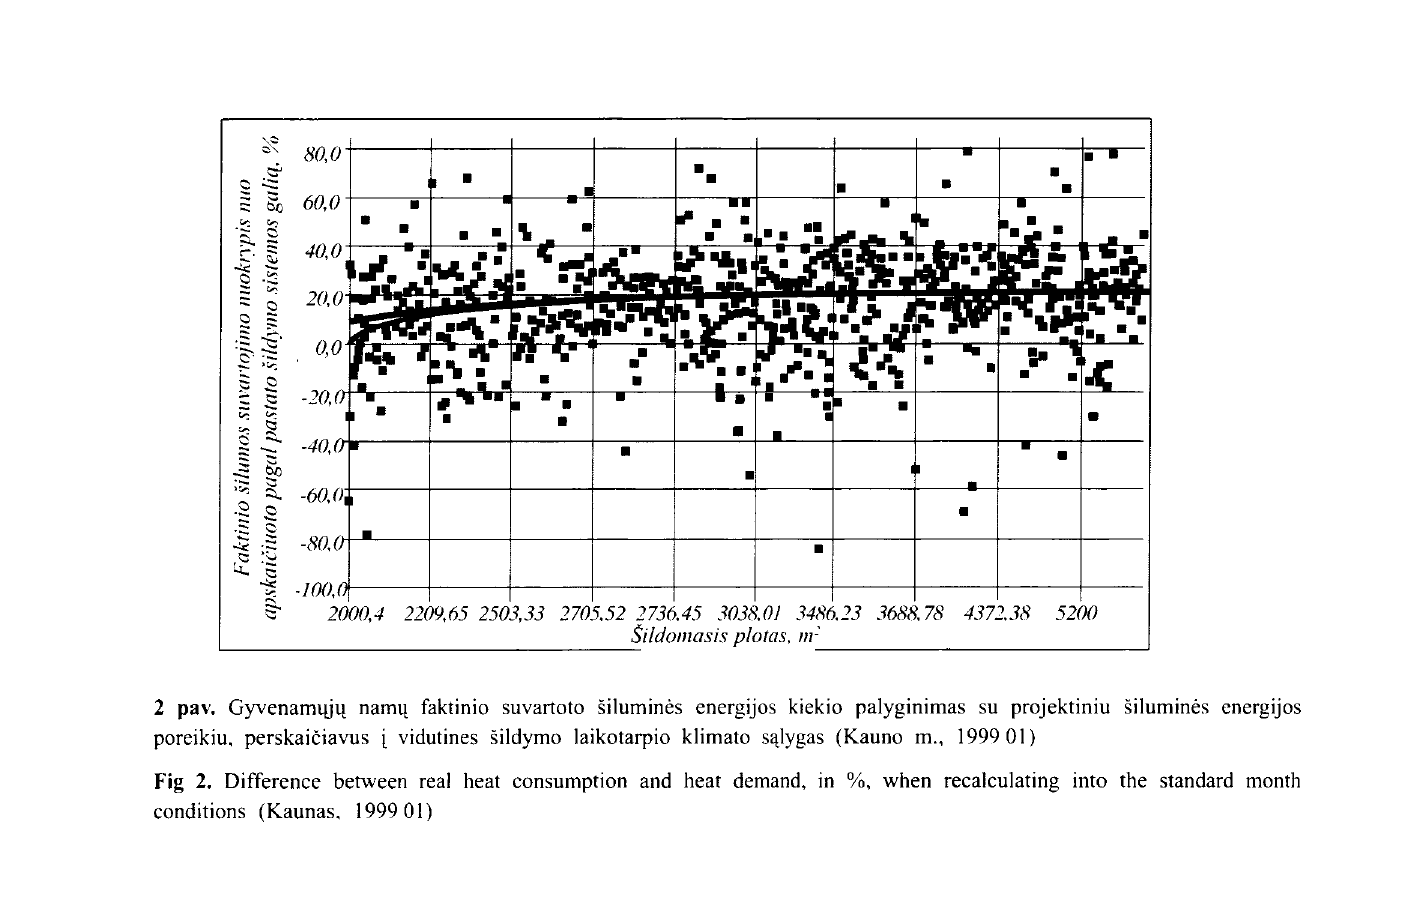
Fig 2. Difference between real heat consumption and heat demand, in %, when recalculating into the standard month conditions (Kaunas. 1999 0 I)